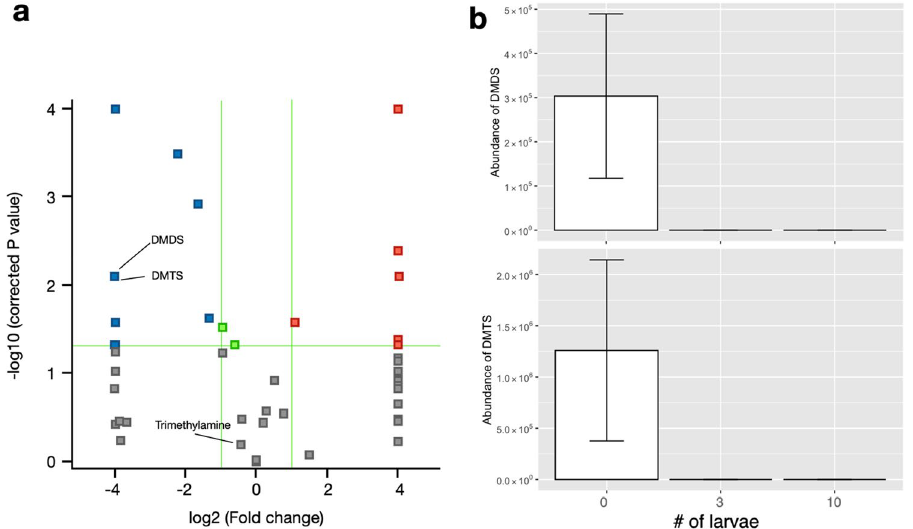
Figure 3. Odor components differentially detected between treatments. ( a ) Volcano plot analysis of odor components detected in 0- and 10-larva vials. Blue and red squares show components detected with higher abundance in 0- and 10-larva vials, respectively. Green lines show thresholds of fold change and P value. ( b ) Abundance of DMDS (upper) and DMTS (lower) in each